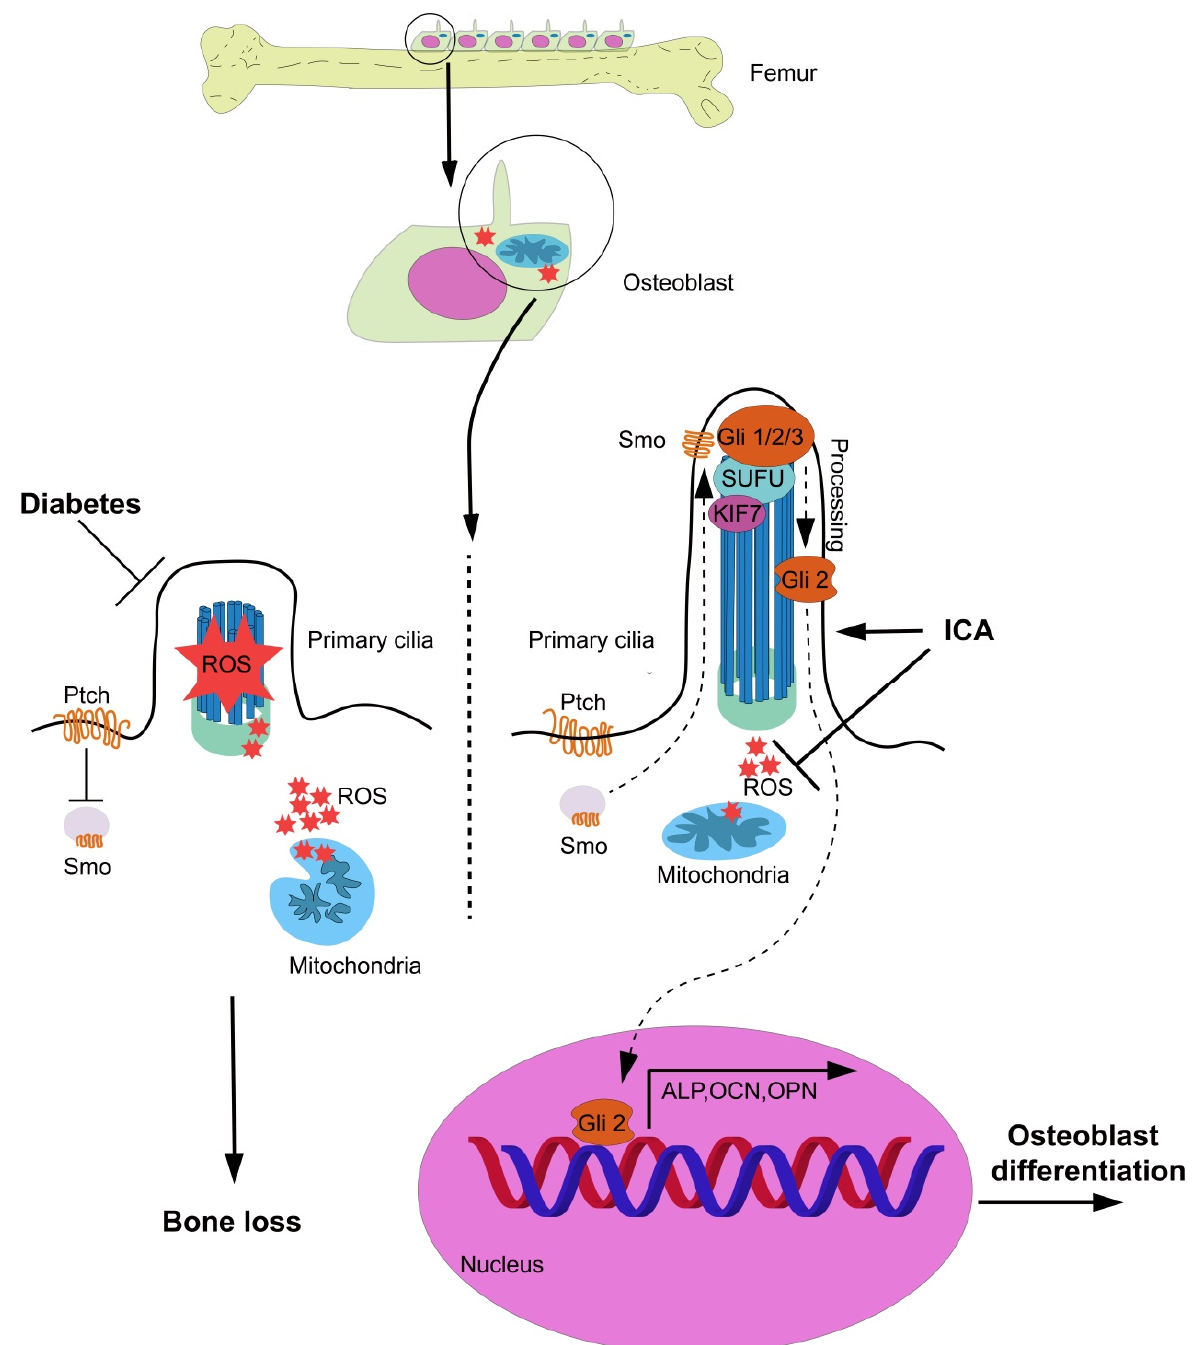
Figure 7. Scheme of the mode of ICA inhibits mitochondrial ROS production to rescue osteoblast differentiation by activate primary cilia/Gli2/osteocalcin signaling.